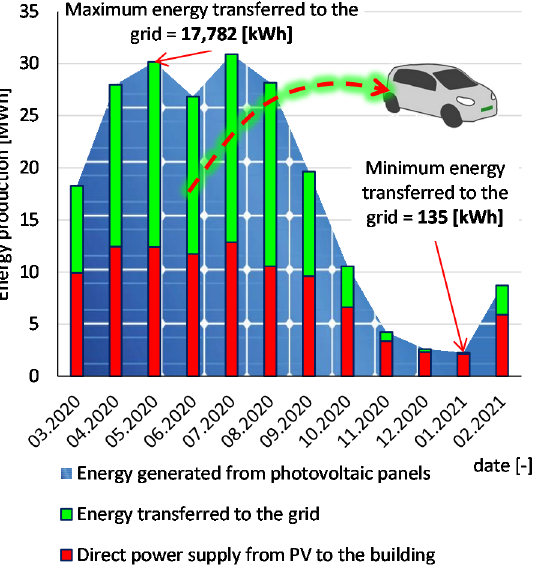
Figure 14. Opportunities for direct energy transfer for electric vehicle charging.